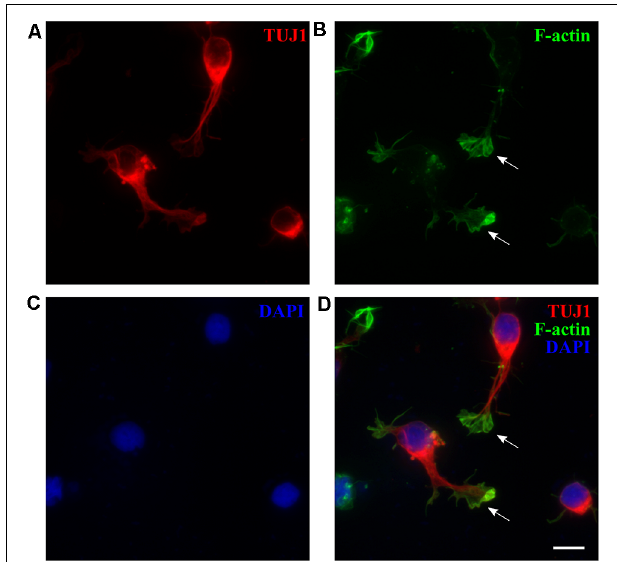
FIGURE 1 | M. domestica -derived neurons and neuronal growth cones (GCs) at DIV1. Primary neuronal cultures prepared from P5 opossums were fixed 24 h after plating and stained for (A) β -tubulin III (TUJ1, red), (B) filamentous (F)-actin (green), (C) nuclear stain 4 (cid:48) ,6-diamidino-2-phenylindole (DAPI; blue) and (D) merged. Arrows indicate GCs identified with F-actin immunostaining. Scale bar, 10 µ m.